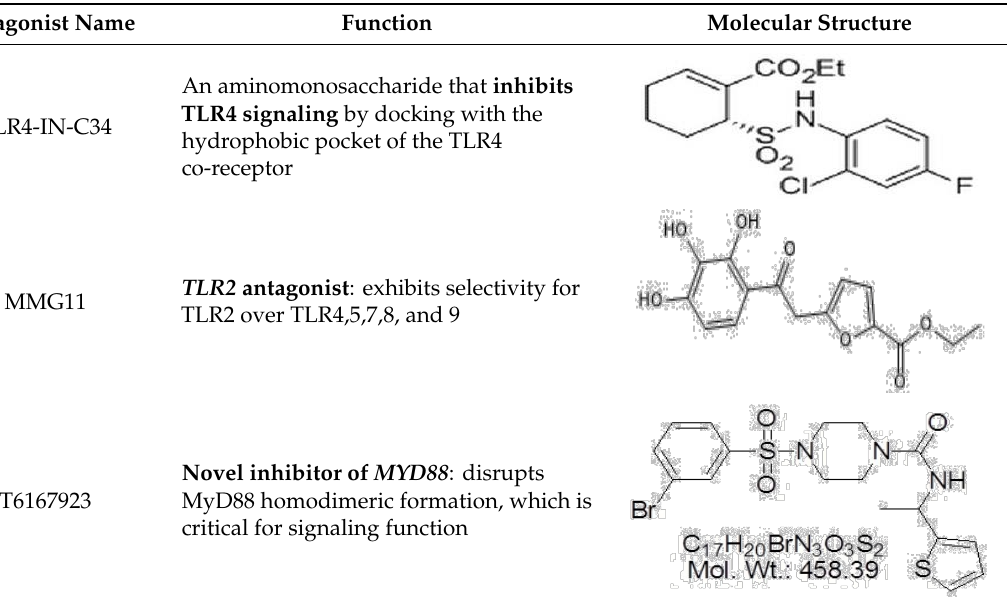
Table 2. Receptor antagonists’ names, functions and their molecular structures.